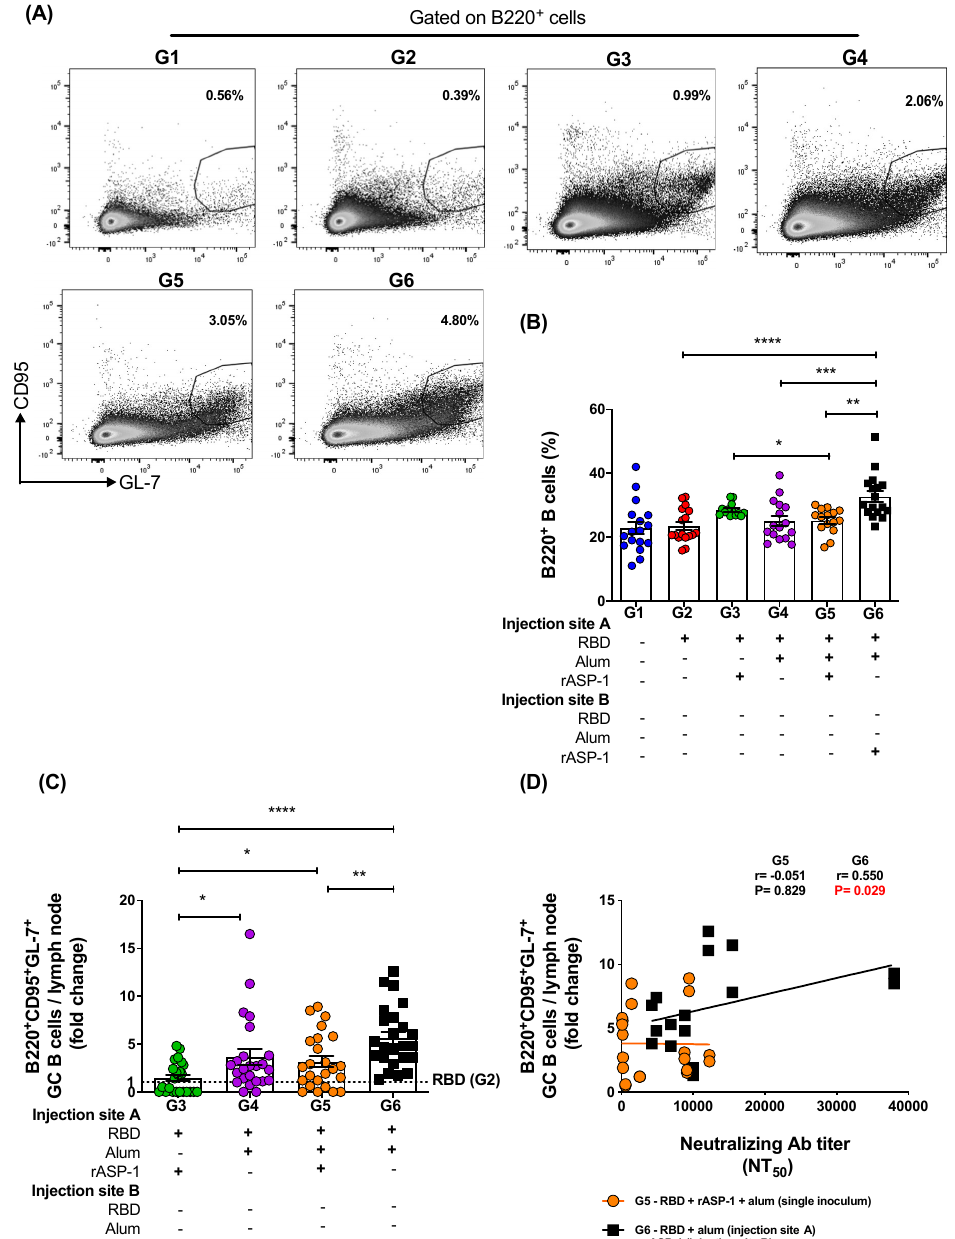
Figure 5. Frequency of B cells and fold increase in the frequency of GC B cells in the lymph nodes (LNs) of immunize mice: C57BL / 6 mice were immunized i.m. with MERS-RBD-Fd with or without alum and rASP-1 alone or together using di ff erent combinations and / or formulations (Table 1 and X-axis legend). The draining LNs were harvested on day 7 post-2nd immunization and the frequency of GC B cells per LN was analyzed. (A) Representative flow cytometry plot in each immunization group. (B) The frequency B cells per LN as well as (C) the fold-increase in the frequency of GC B cells per LN was analyzed. The frequency of GC B cells per LN in all the adjuvanted-vaccine groups was normalized against the RBD vaccine group (G2). (D) The fold increase in the frequencies of GC B cells per LN in groups G5 and G6 were correlated with the NT 50 titers determined in each serum sample of the corresponding mice. The experiment was repeated at least twice with 3 to 5 mice per group and the data are represented as mean and standard error. “ + ” indicates the presence and “ − “ indicates the absence of the protein or adjuvants in the formulation. Statistics was performed using one-way ANOVA with Tukey’s multiple comparison. p < 0.05: *, p < 0.01: **, p < 0.001: ***, p < 0.0001: ****. Spearman correlation was performed to determine the association of GC B cells with neutralizing antibody